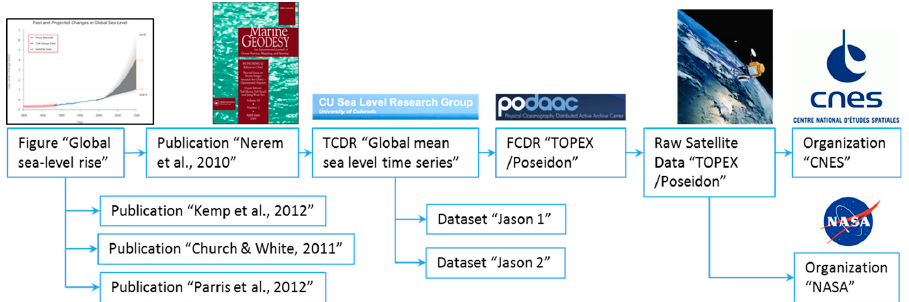
Figure 2. Tracing CNES’ and NASA’s contribution to the global sea-level rise scenario results. The